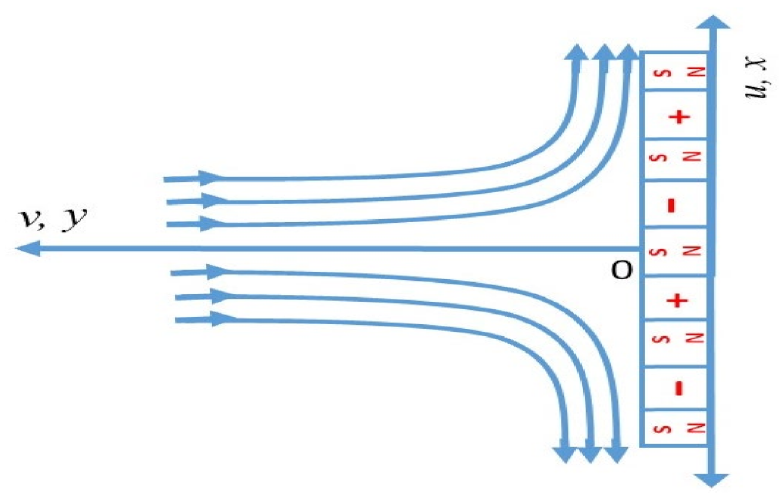
Figure 1. Flow pattern of Casson hybrid nanofluid over vertical Riga